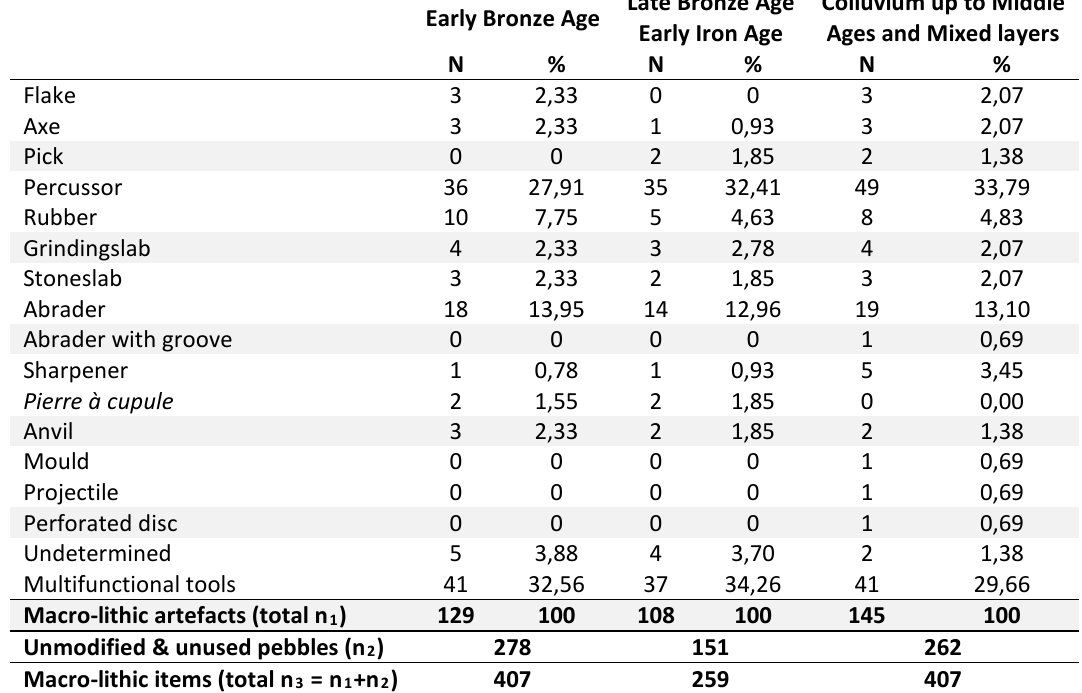
Figure 3. Absolute quantities of different macro-lithic items recovered in the wet soil area of Bruszczewo (above), and their percentage frequencies in each of the occupation periods of the site (below). Note the considerably high amount of multifunctional artefacts resulted from the combination of abraders, percussors and, or, pierre à cupules . In the above graphic artefacts are grouped according to the main wear mechanisms macroscopically recognizable on their active surfaces, which are the basis for the subsequent use-wear analysis. (See Table 2.) Table 2. Data from Figure